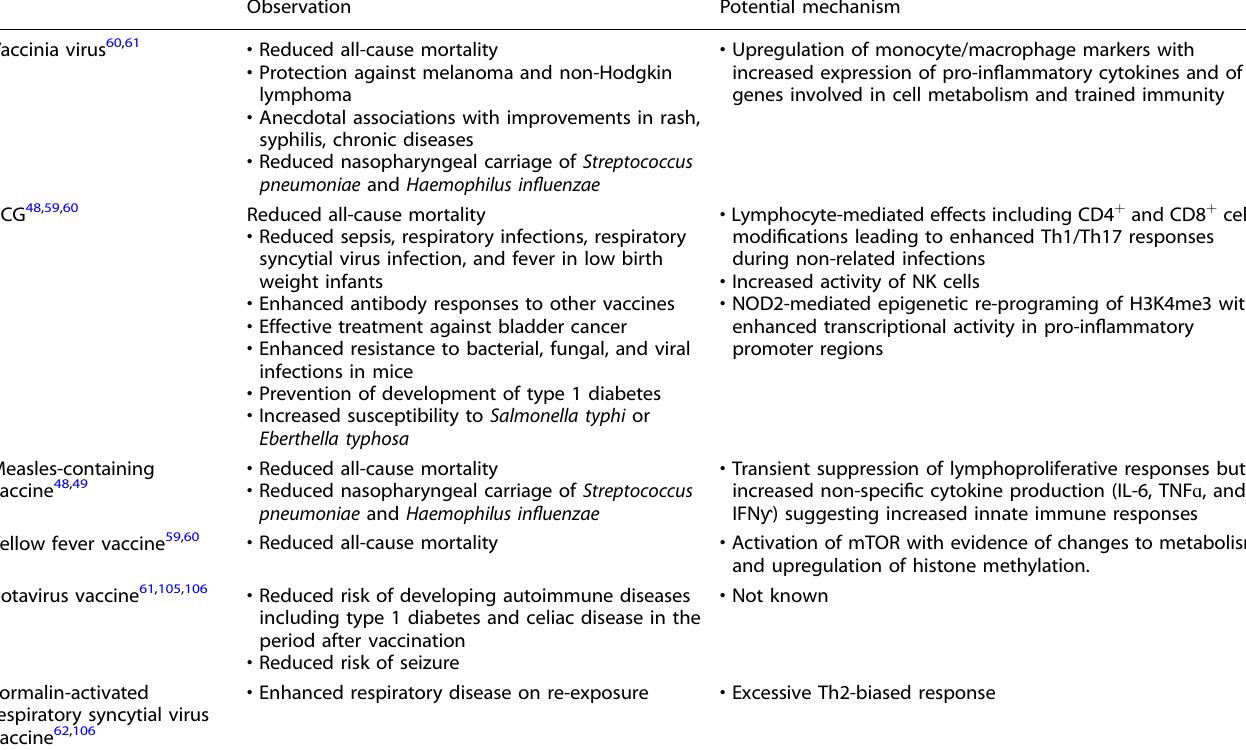
Table 1. Downstream effects of vaccination. Observation Potential mechanism Vaccinia virus